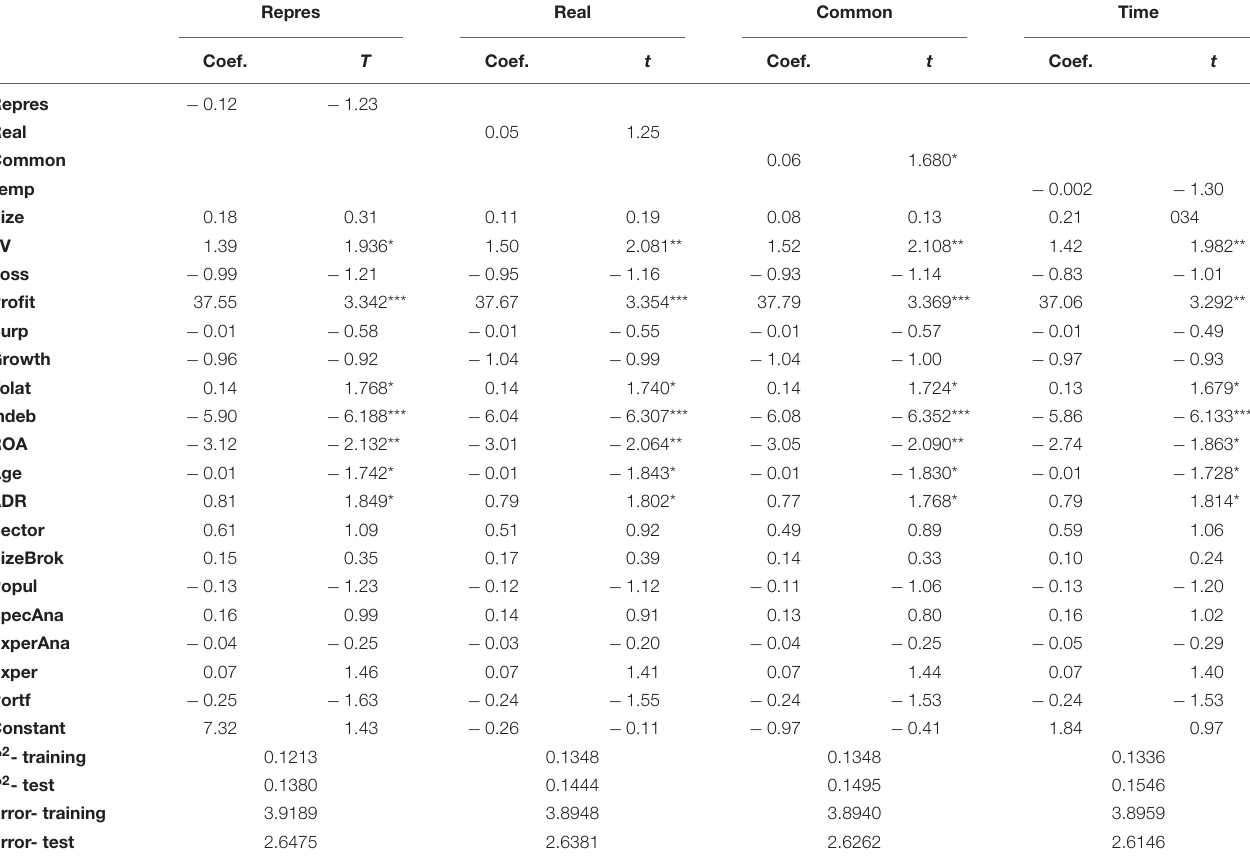
TABLE 4 | Regression in OLS, carried out in the Caret package, for